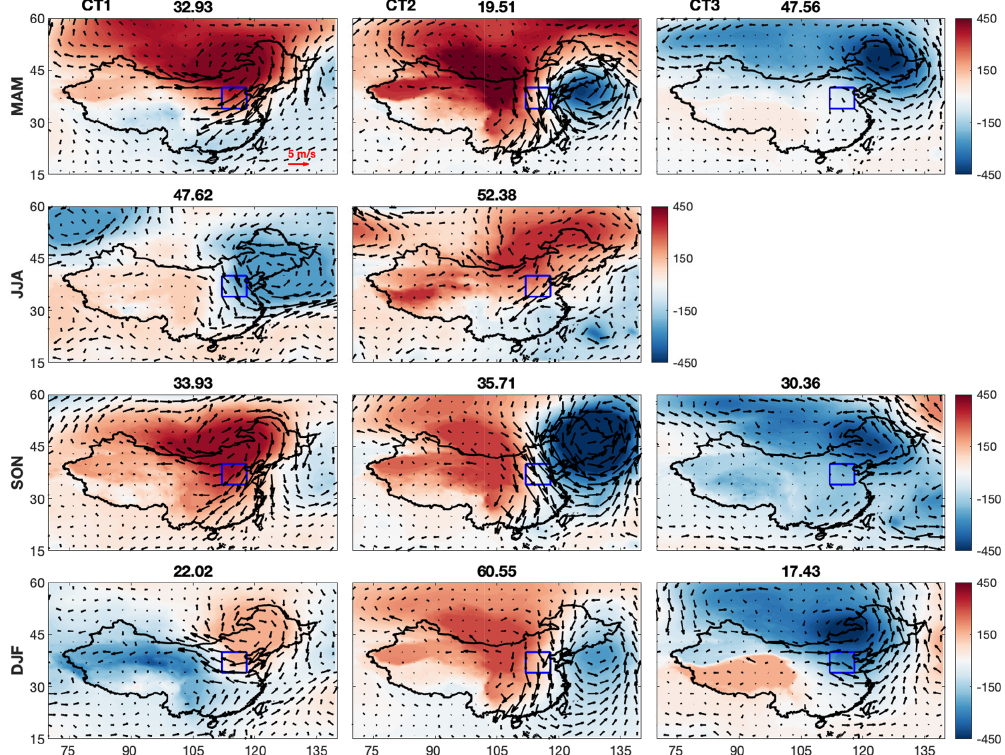
Figure 5. Distribution of the geopotential height anomalies (shaded, unit: m 2 s − 2 ) and wind field anomalies at 925hPa for each circulation type. The number over each subplot indicates the occurrence frequency of the specific circulation type. The solid blue box is the location of the domain region covering the 28 pollution channel